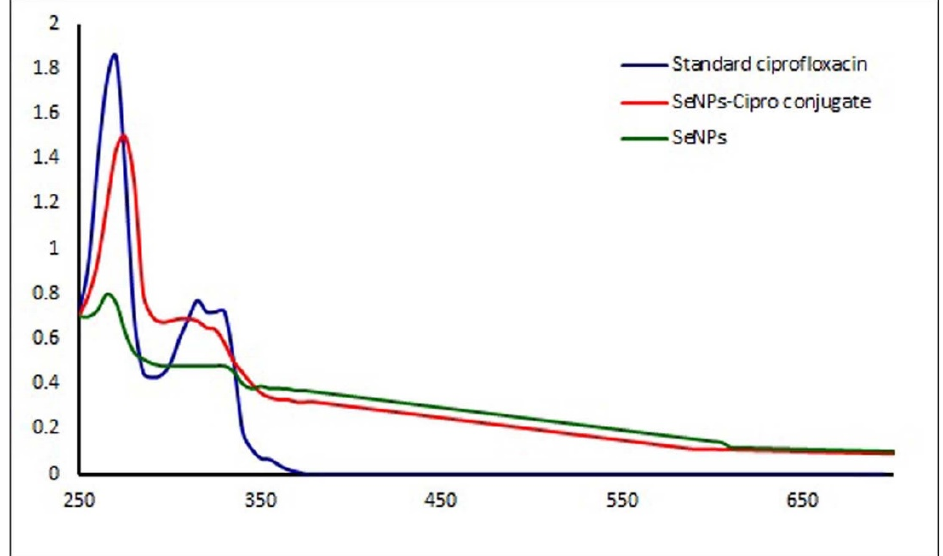
Figure 3. UV–Visible spectra of the combinations used for the